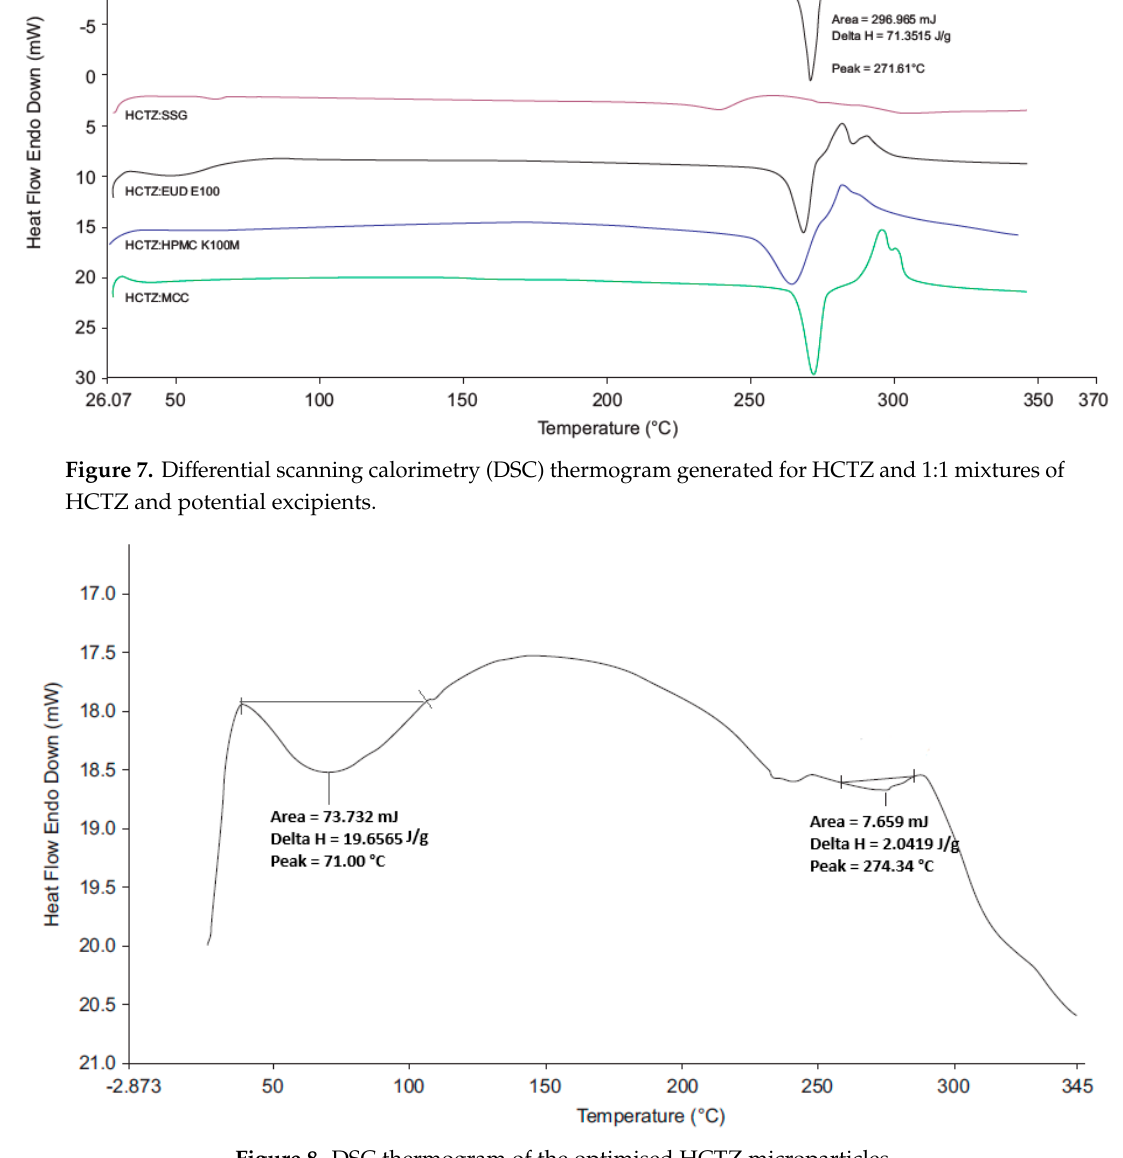
Figure 8. DSC thermogram of the optimised HCTZ microparticles.